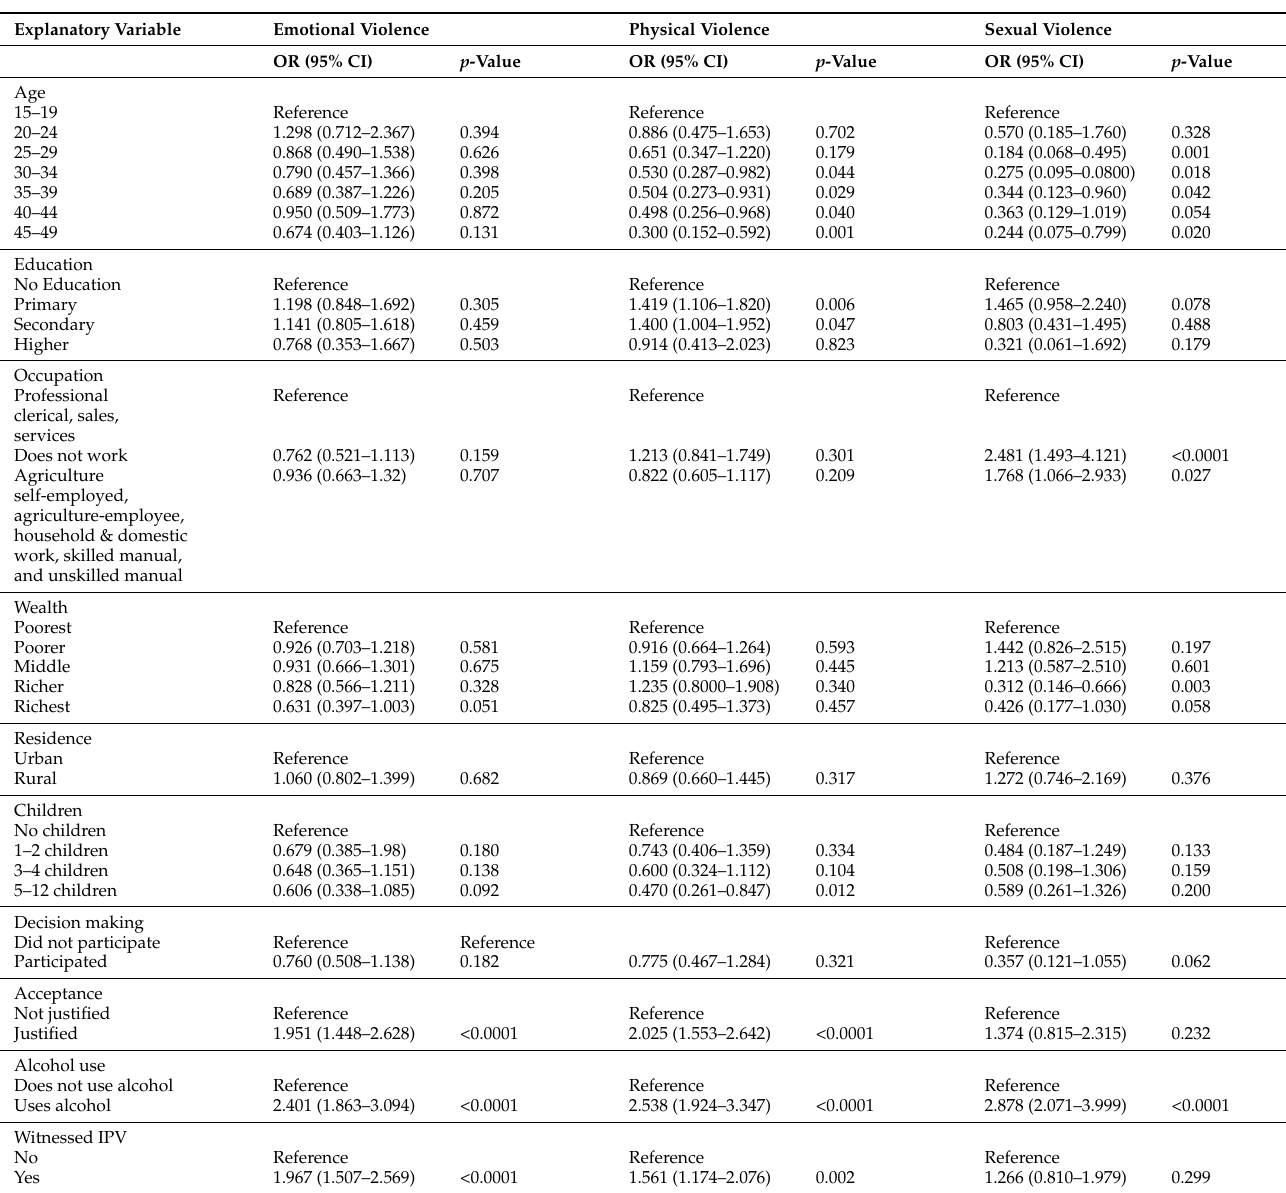
Table 3. Odds ratios, significance levels, and 95% confidence intervals for the associations between three types of intimate partner violence with the selected variables—Liberia DHS